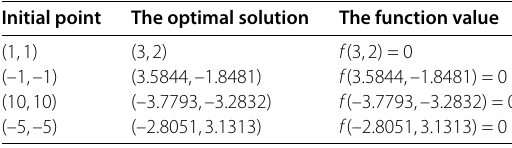
Table 2 The initial points corresponding the optimal points with the Himmelblau function Initial point The optimal